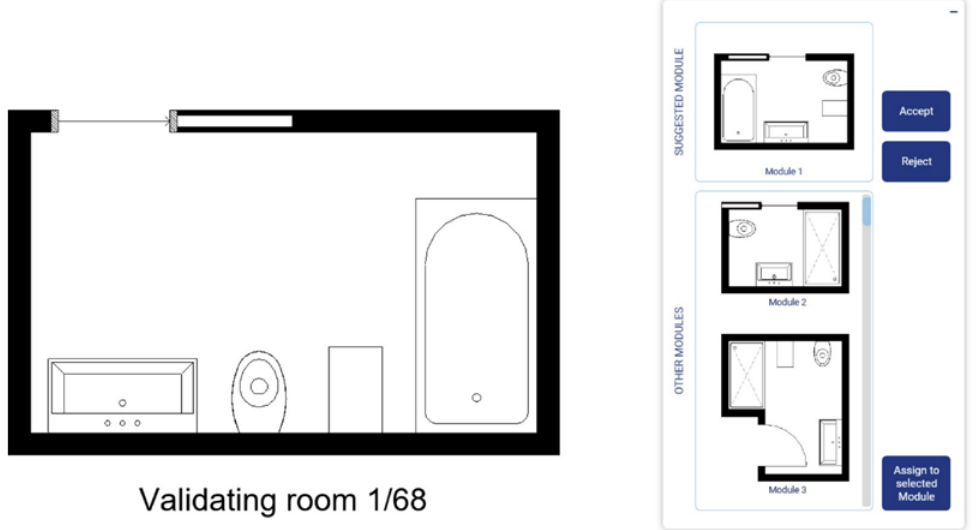
Figure 2. Validation interface of the developed software application.